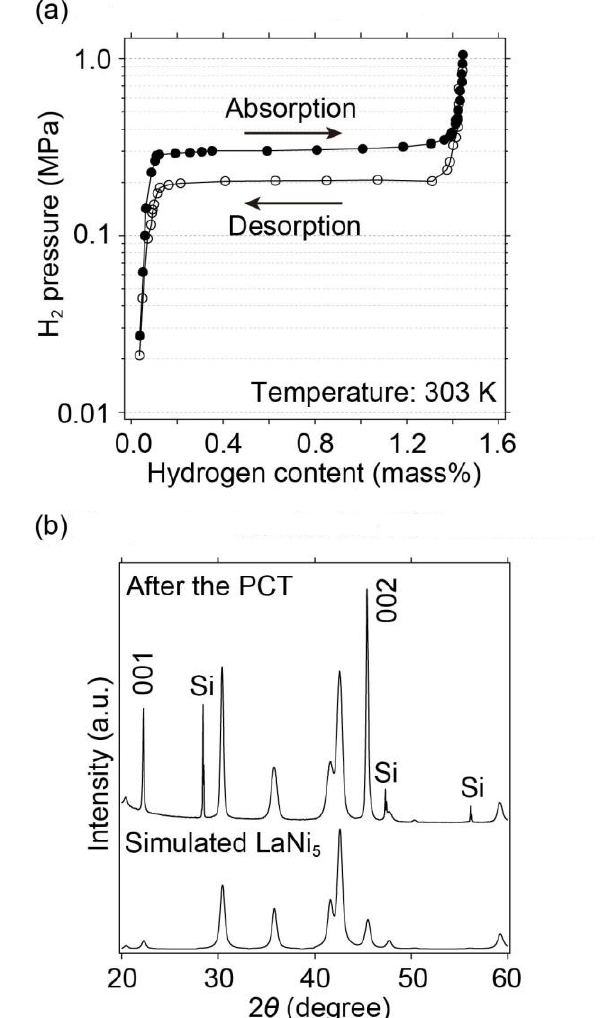
Figure 2. ( a ) PCT curves of LaNi 5 measured at 303 K, and ( b ) X-ray diffraction pattern after the PCT measurements with simulated X-ray diffraction pattern of LaNi 5 . In the X-ray diffraction pattern after the PCT measurement, strong intensities of (001) and (002) reflections originated into a preferred orientation of (00 l ) reflection. Si is added as an internal standard in the X-ray diffraction pattern after the PCT measurement.